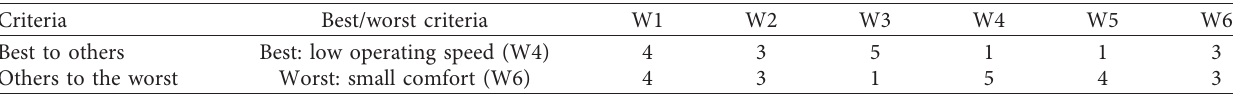
Table 6: Internal weaknesses (IW)-pairwise comparison vector.